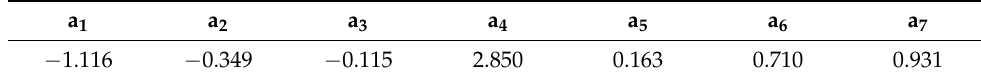
Table 4. Coefficient of the fitting formula (30–60 ◦ ).